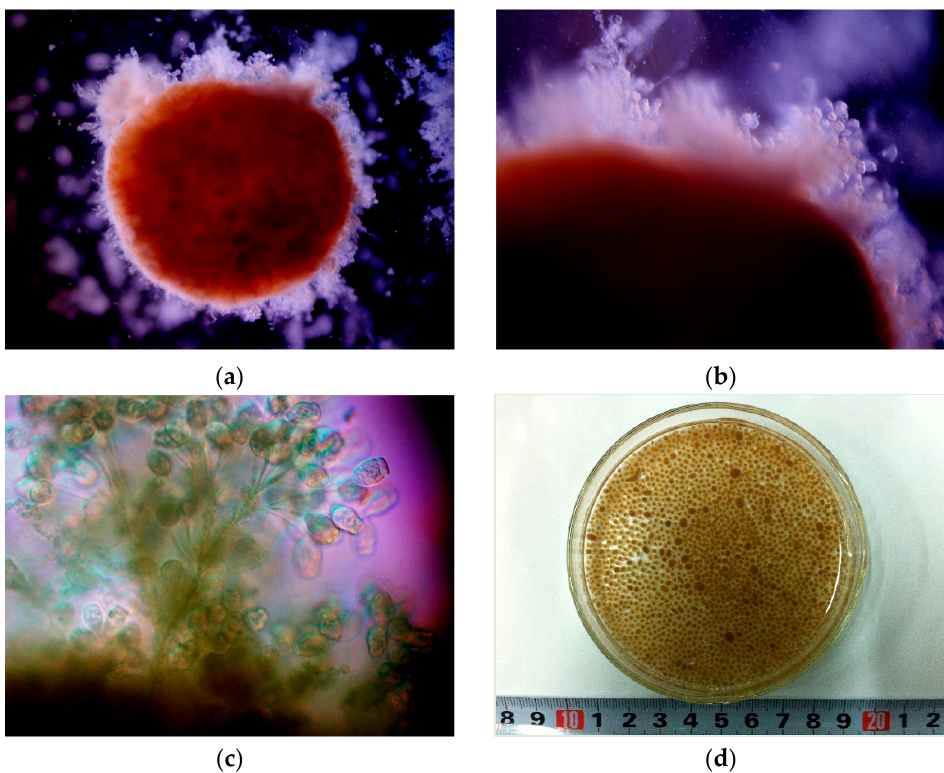
Figure 6. Granules with stalked ciliates ( Epistylis sp.) in the surface from SBR2 (domestic wastewater). ( a ) A granule from SBR2; ( b ) the surface of a granule; ( c ) Epistylis sp. in the surface of a granule; ( d ) granules with stalked ciliates on day 120. Scale bar = 100 μ m.